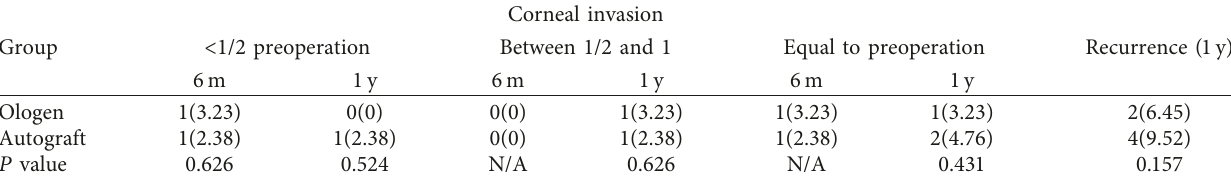
Table 2: The postoperative recurrence rates in both groups.